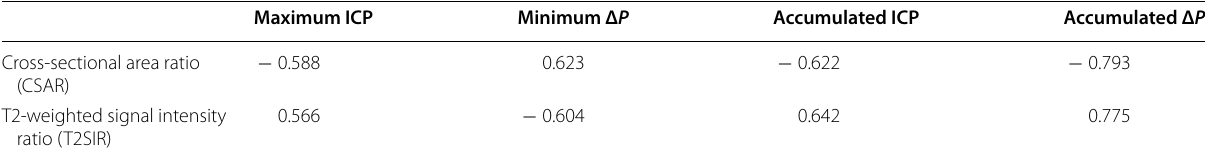
Table 2 Pearson product-moment correlation coefficients (PPCCs) between the ICP data and MR imaging data